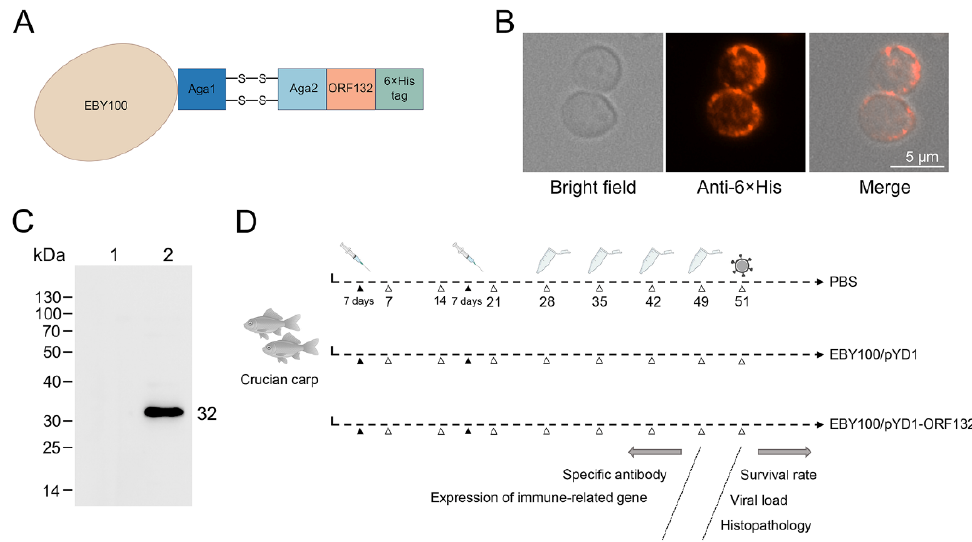
Figure 1. The construction and characterization of ORF132 on the EBY100 surface. ( A ) Schematic diagram of recombinant yeast vaccine construction. The epitope antigen of ORF132 was displayed on the surface of cell wall by Aga1 and Aga2. ( B ) ORF132 expressed on the surface of EBY100 yeast cells were testified using confocal microscopy. bar = 5 μ m. ( C ) ORF132 protein was determined by Western blot. 1, EBY100/pYD1; 2, EBY100/pYD1-ORF132. ( D ) Schematic illustration of vaccine immunization for crucian carp.